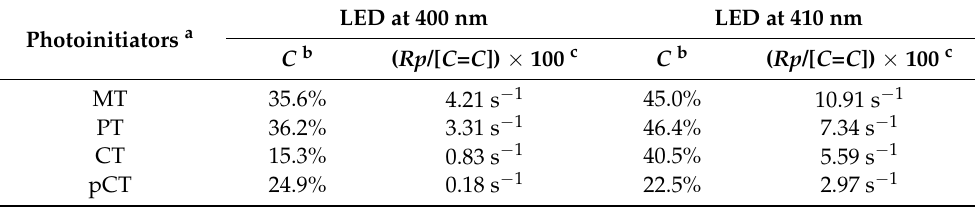
Figure 5. Photopolymerization profiles (double bond conversion vs. time) of TMPTA in laminate upon exposure to ( a ) LED at 400 nm and ( b ) LED at 410 nm in the presence of triazine derivative-based photoinitiators (molar concentrations of all triazine moieties are 5.0 µ mol/g). Table 2. Double bond conversions and polymerization rates of TMPTA in the presence of triazine derivatives (MT, PT, CT, and pCT) upon exposure to the LED at 400 nm (6.4 mW cm − 2 ) and LED at 410 nm (110 mW cm − 2 ) for 300